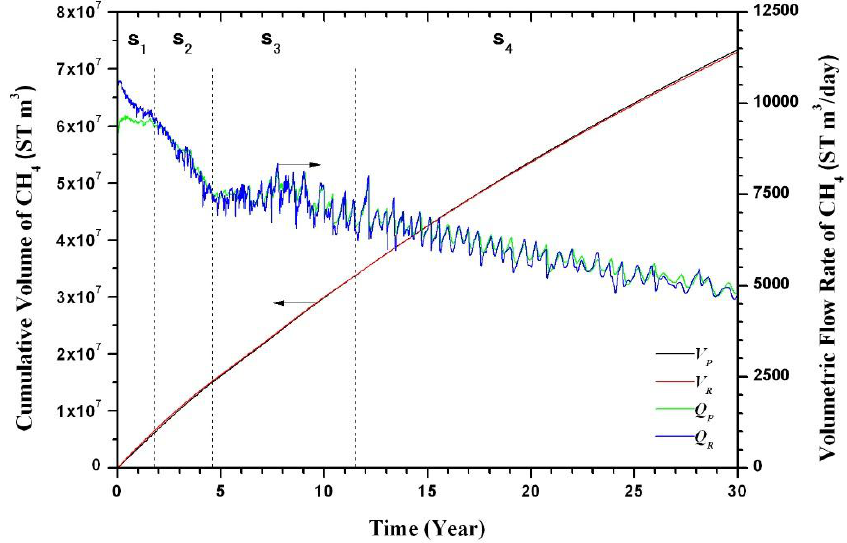
Figure 7. Reference case: evolution of cumulative volume of produced gas ( V p ), cumulative volume of dissociated gas ( V R ), volumetric flow rate of produced gas ( Q p ), and volumetric flow rate of dissociated gas ( Q R ) overtime.